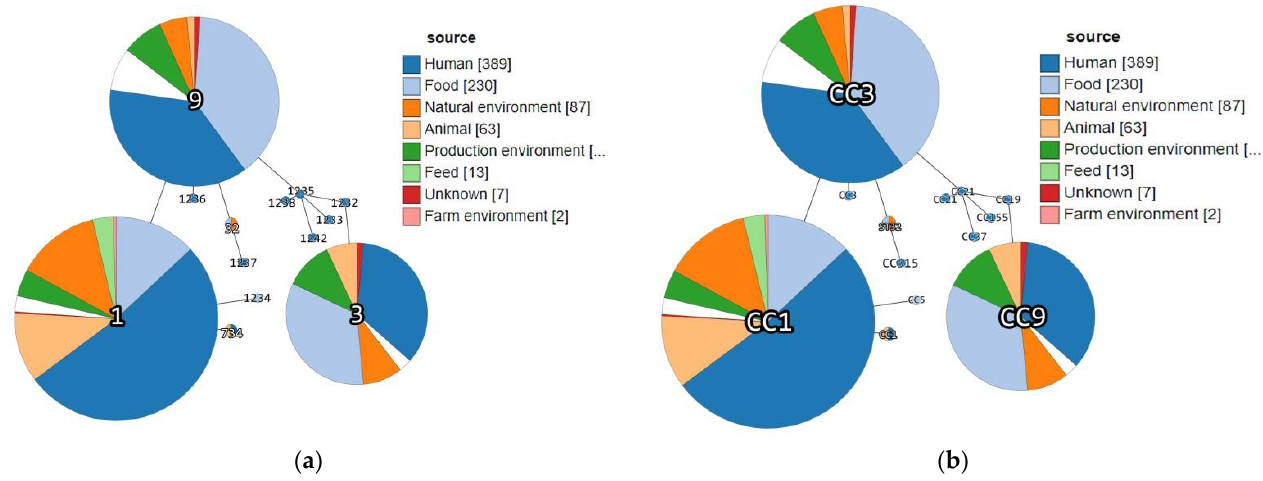
Figure 5. Minimum spanning tree demonstrating genetic relatedness between L. monocytogenes strains isolated in the Republic of Serbia in 2004 – 2012 and 2019, respectively, from animal, human, food, and environmental sources. Each individual circle represents either ( a ) one sequence type (ST) or ( b ) single clonal complex CC. The circle’s sizes are proportional to the number of strains. Links between circles represent the number of allelic mismatches between either ( a ) CCs or ( b ) STs ( Supplemental Data 1 ) .